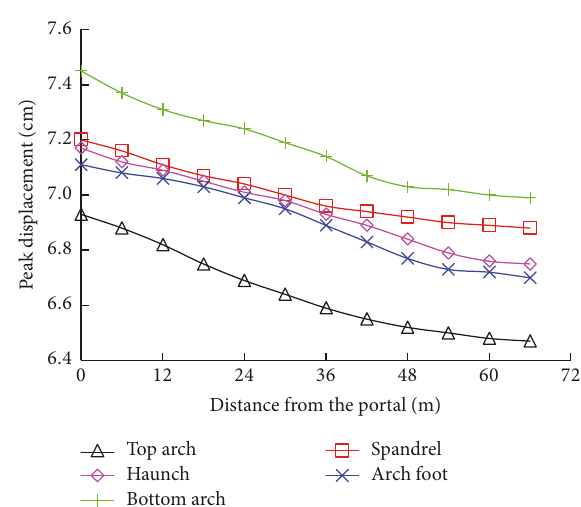
Figure 8: 𝑧 -peak displacements variation of monitoring points along tunnel